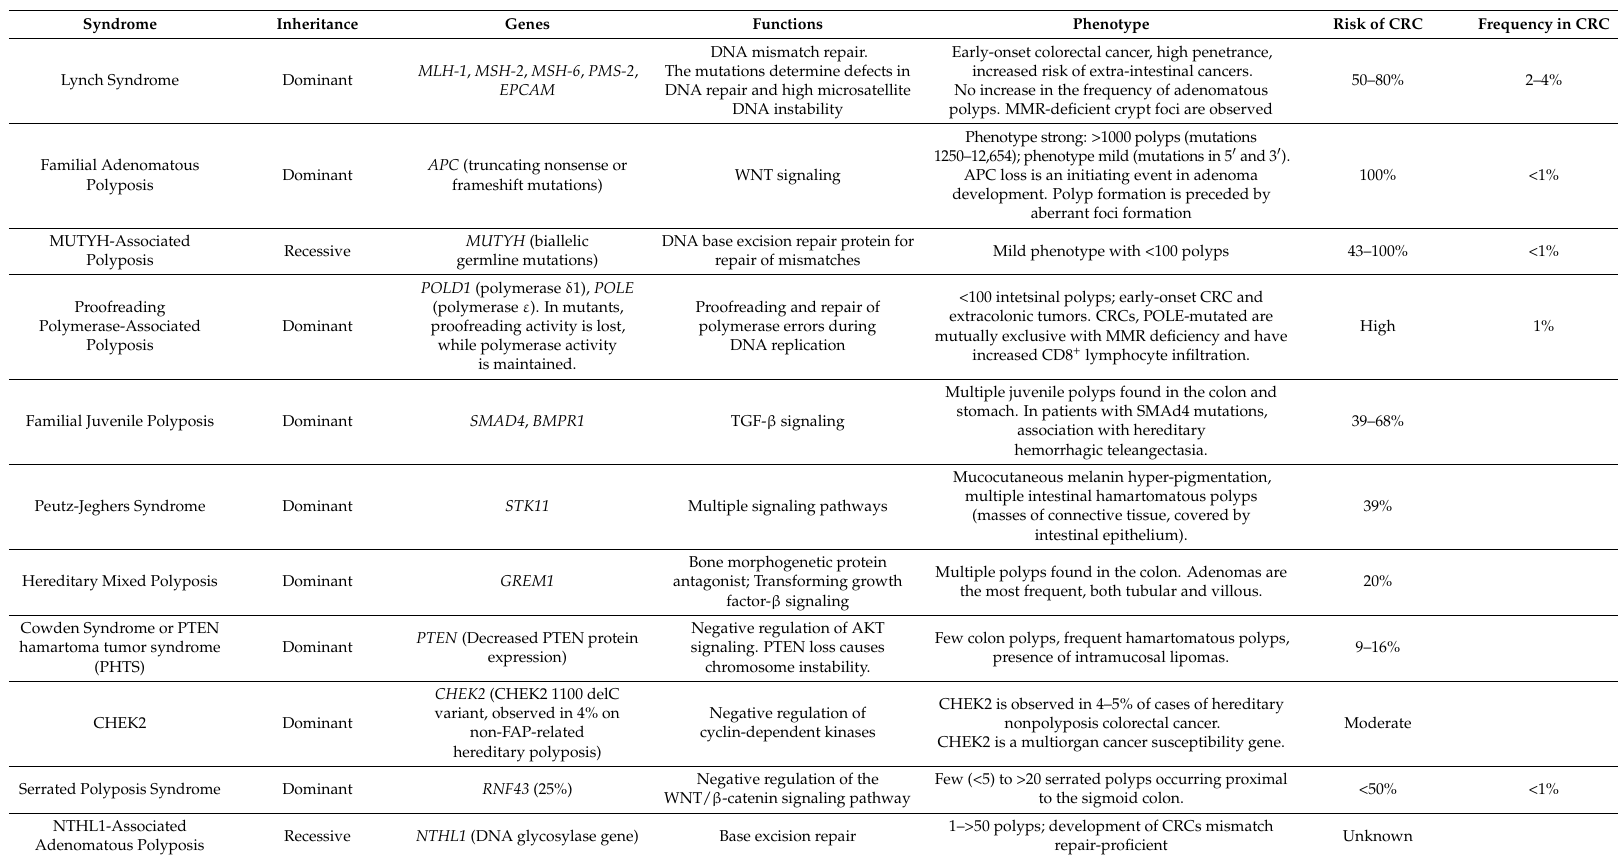
Table 1. Hereditary syndromes associated with frequent colorectal cancer